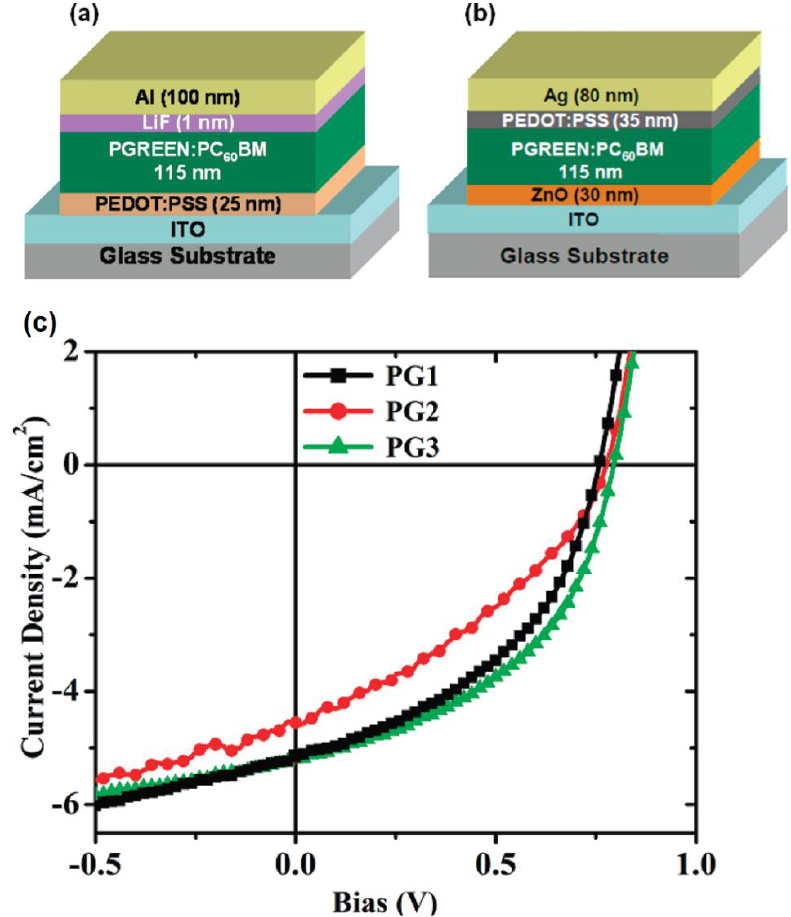
Figure 8. Schematic diagram of PGREEN polymer solar cells with ( a ) conventional and ( b ) inverted geometry. ( c ) Current – voltage plots for illuminated conventional geometry cells (0.04 cm 2 ) for each of the three polymer batches produced under identical processing conditions. [82]. Reproduced with permission from ACS.